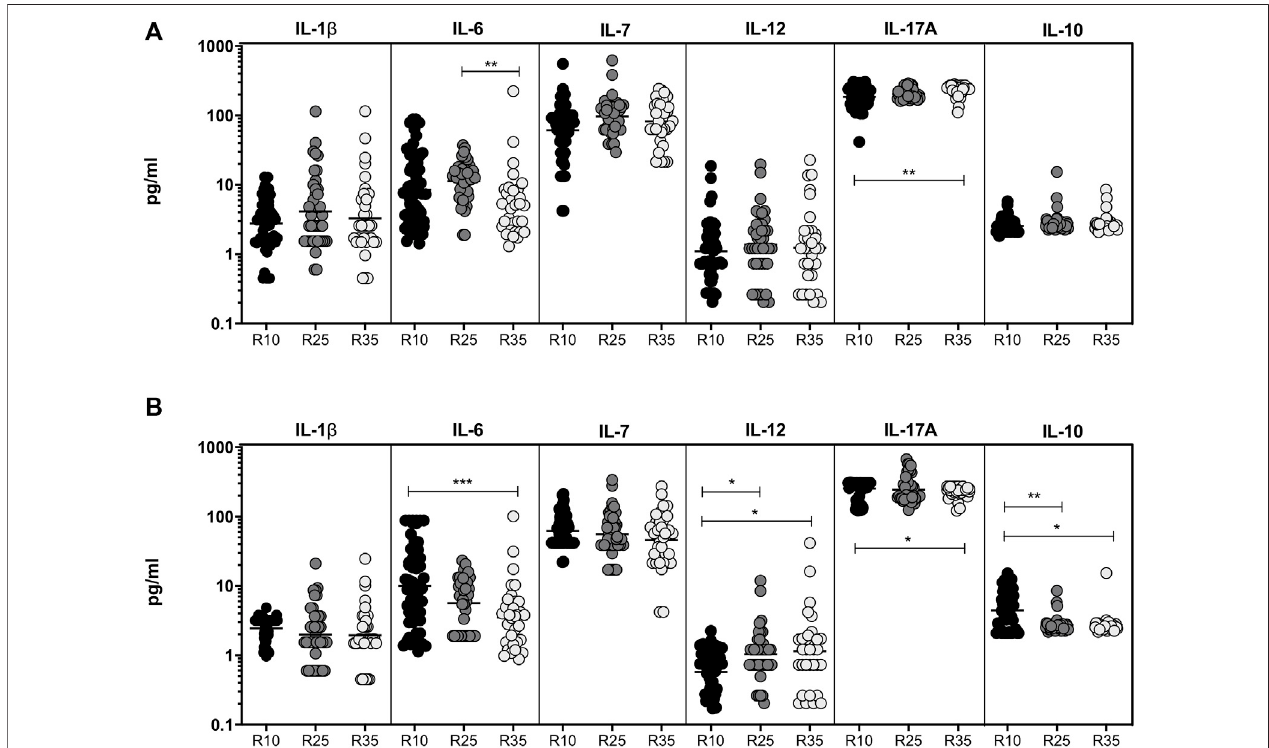
FIGURE2| Alteredpro-in fl ammatoryanddecreasedregulatorycytokinesareassociatedwithHighdoserifampicintreatedPTBindividualsatthesecondmonth (A) Baseline plasma levels of pro-in fl ammatory (IL-1 β , IL-6, IL-7, IL-12, and IL-17A) and regulatory (IL-10) cytokines between the three different rifampicin (R10 [ n = 57], R25 [ n = 42], and R35 [ n = 33]) treated arm of PTB individuals. (B) Second month plasma levels of pro-in fl ammatory (IL-1 β , IL-6, IL-7, IL-12, and IL-17A) and regulatory (IL-10) cytokines between the three different rifampicin (R10 [ n = 57], R25 [ n = 42], and R35 [n = 33]) treated arm of PTB individuals. We used Kruskal – Wallis test with Dunn ’ s multiple comparisons to measure the p values and each individual were denoted using scatter